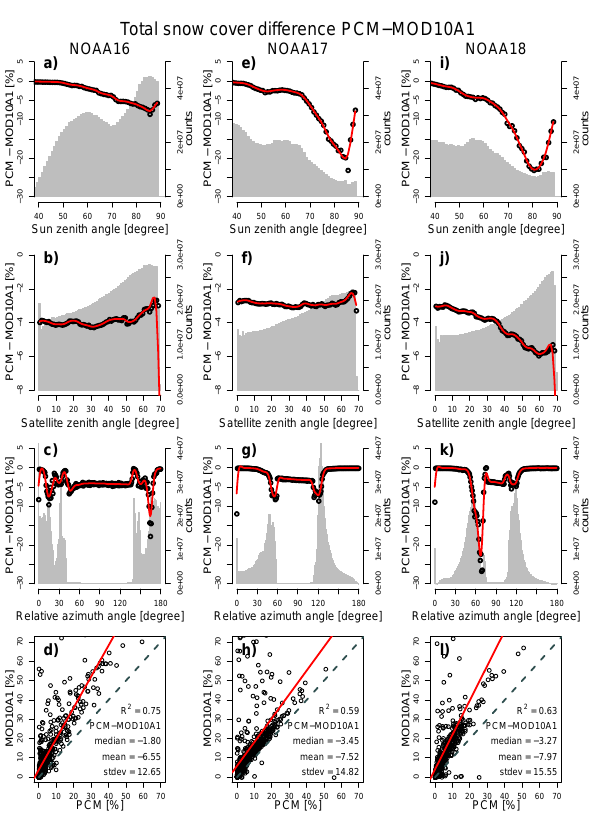
Fig. 13. Total snow cover difference PCM–MOD10A1 as a function of selected variables derived from annual pixel counts for the years 2011 (NOAA16) and 2008 (NOAA17 and 18). Data frequency is presented as grey-shaded histograms. Bottom panels present the to- tal snow cover scatter plots derived from estimates computed over each scene. Red lines denote trends. For details see Sect. 4.2.